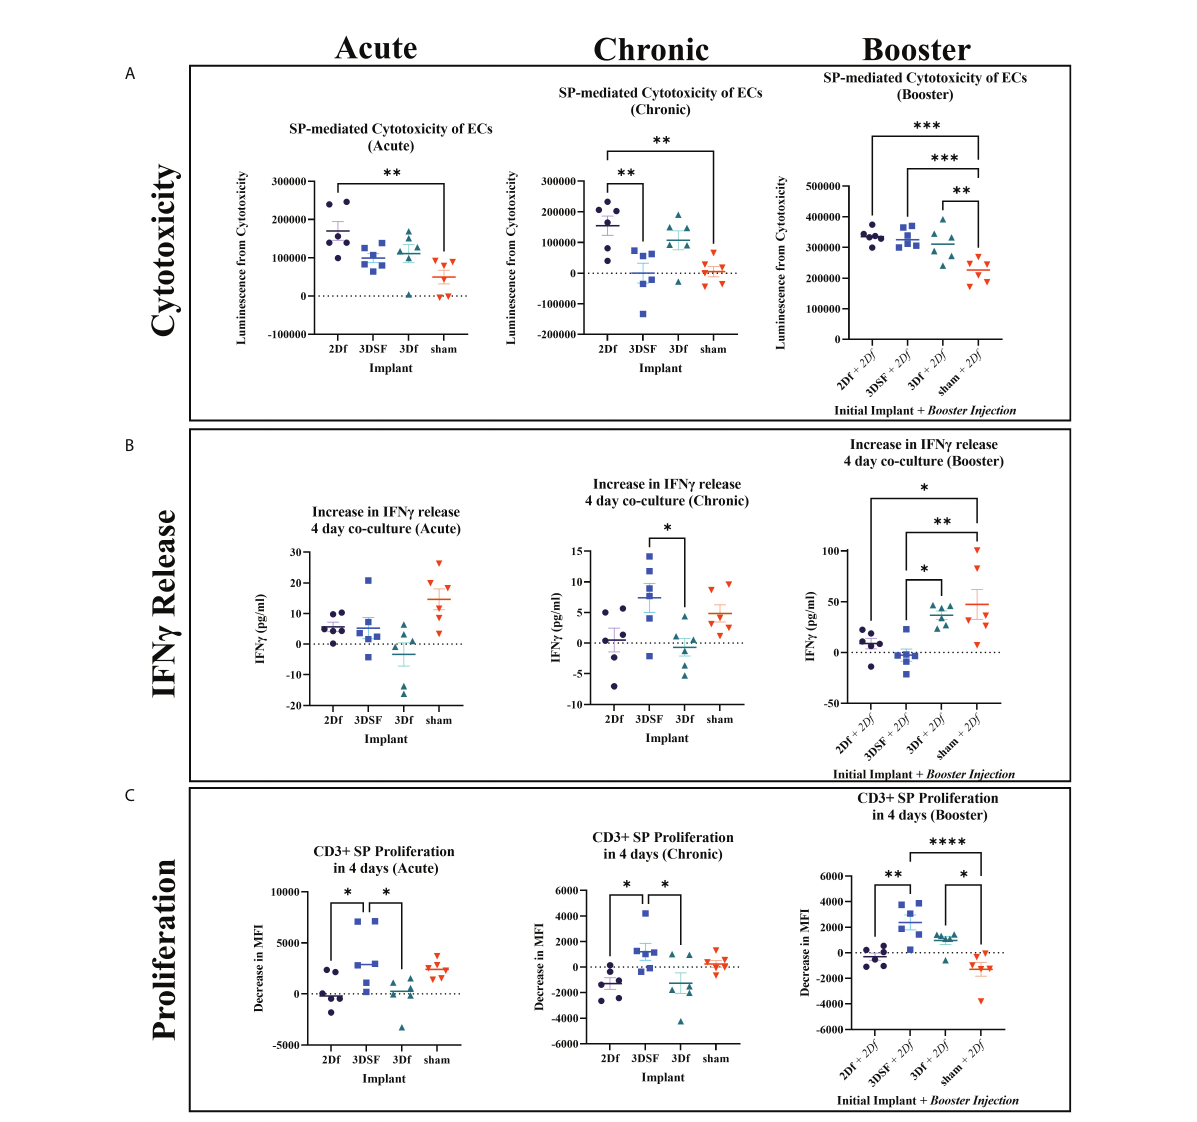
FIGURE 4 In vivo assays measuring cytotoxicity, IFN g release, and proliferation from SPs isolated from rats implanted with allogeneic ECs. (A) Cytotoxicity was elevated for 2Df EC implanted rats relative sham for all groups while 3DSF 3D implanted acute and chronic rats had lower cytotoxicity. (B) 3DSF and sham SPs showed elevated IFN g release in co-culture wells compared to SP alone wells while 2Df and 3Df did not. At day 4, SPs from 3Df and sham animals showed signi fi cantly elevated IFN g release in co-culture wells after a second in vivo injection of 2Df ECs. (C) MFI, mean fl uorescence intensity. 3DSF SPs showed greater proliferation than 2Df and 3Df SPs in both the acute and chronic groups. 3DSF and 3Df SPs show greater proliferation than sham SPs when rats receive a booster injection of 2Df ECs. Statistics: Ordinary one-way ANOVA. n=6. *(P